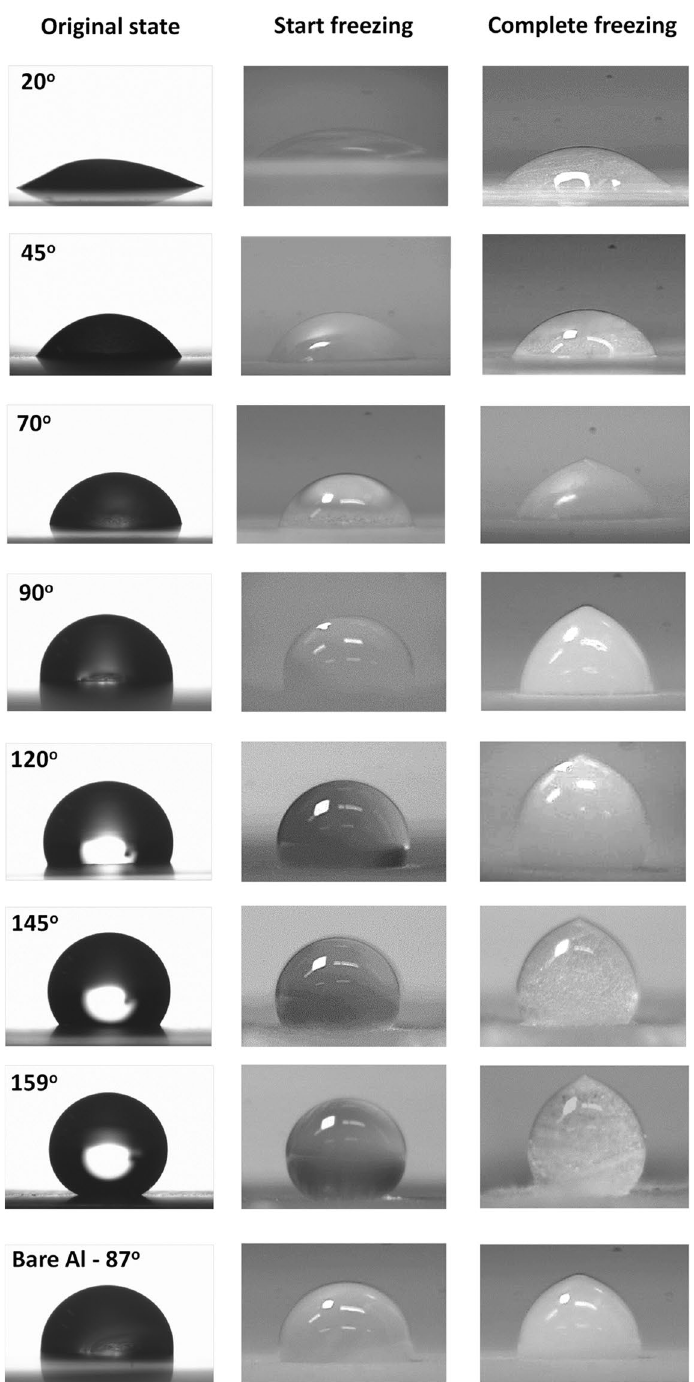
Figure 8. Icing formation on surfaces with different wettability observed by high-speed